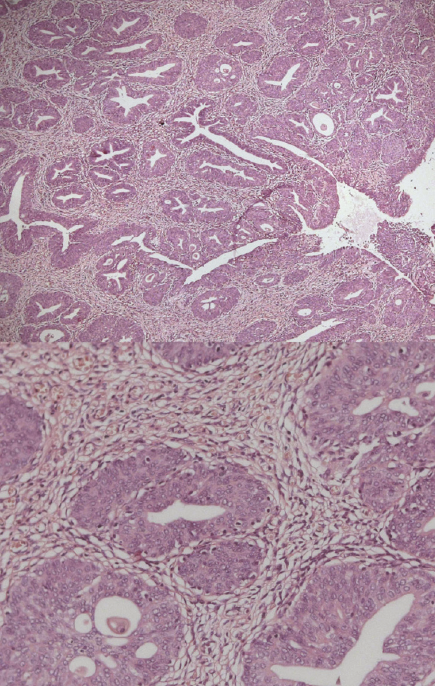
Figure 3 - Histology showing glandular structures lined with mucus-secreting cubic and columnar cells consistent with cystitis glandularis